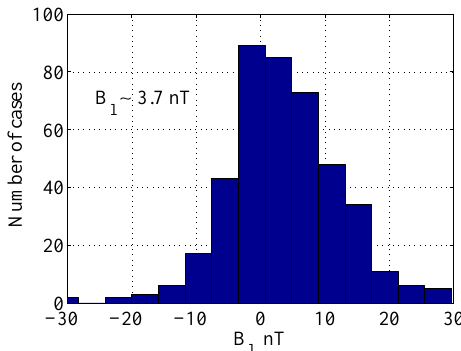
Figure 6. The position of the current density peak j tmg relative B l magnetic